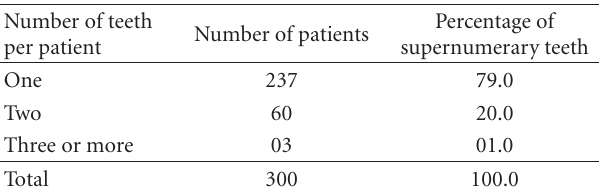
Table 2: Distribution of supernumerary teeth by number per